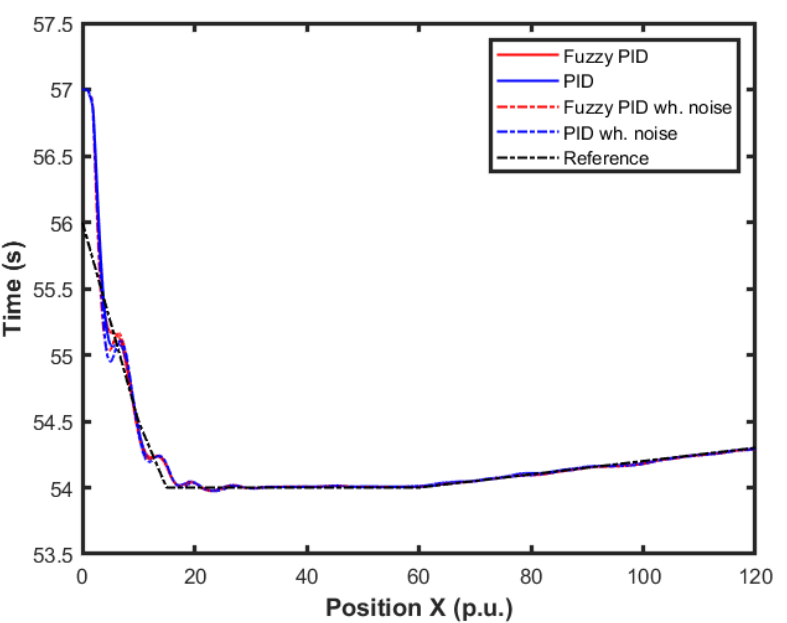
Figure 15. Comparison of the proposed method among others for position control in the X-axis.